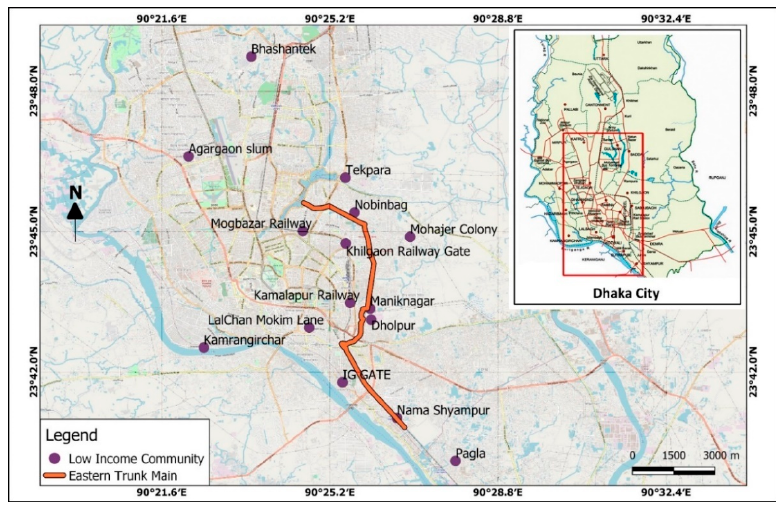
Figure 1. Study location of the low-income communities (LICs) with proposed trunk main.